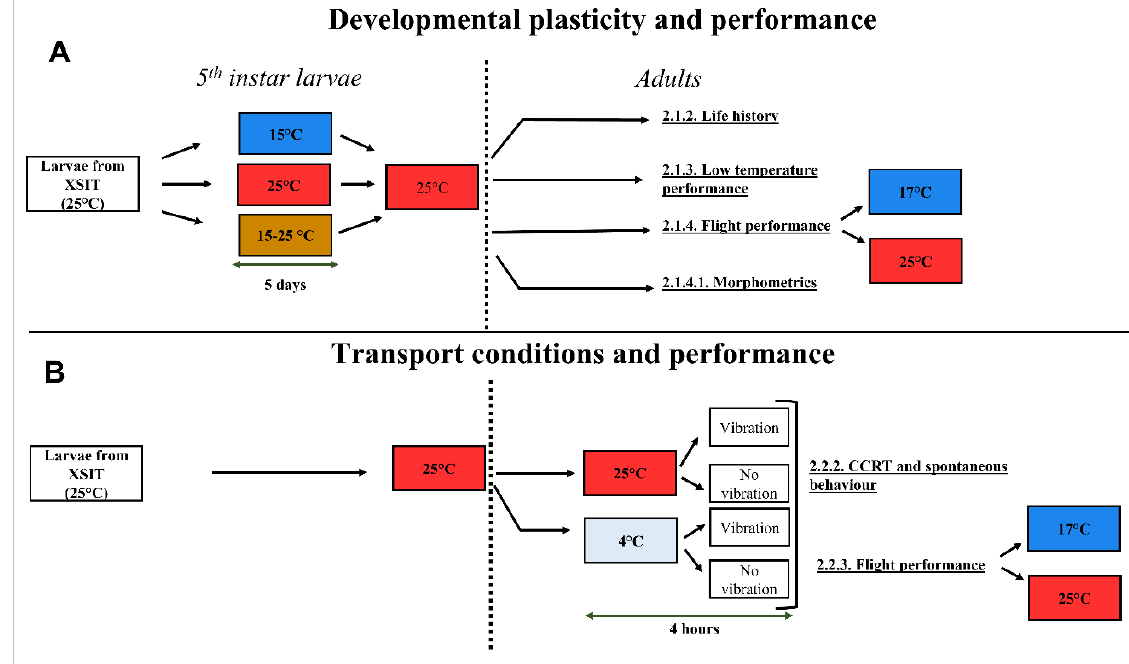
Figure 1. Schematic diagram of experimental protocols showing 5th instar FCM larvae experiencing ( A ) developmental acclimation (representing a change in rearing conditions) or ( B ) transport condi- tions (adults experiencing temperature and vibration pre-treatments). Several traits were measured to assess the effects of these treatments on performance of FCM. Details of the experiments are pre- sented in Sections 2.1 and 2.2. (XSIT- X Sterile Insect Technique (Pty) Ltd, Citrusdal, South Africa.; CCRT—chill coma recovery time).